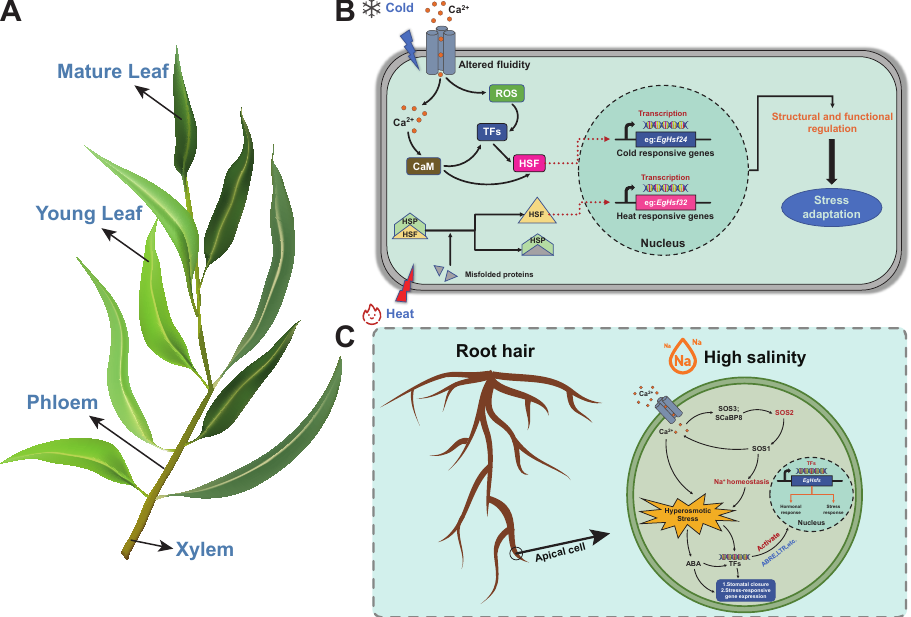
Figure 9. Abiotic stress (salt and temperature) response mechanisms of the Hsf gene in Eucalyp- tus . ( A ) Schematic diagram of the morphology of the Eucalyptus branch. The diagram includes mature leaves, young leaves, phloem and xylem. These parts (including the roots) are the key parts of Eucalyptus in relation to abiotic stress perception and response. ( B ) Schematic diagram of the temperature stress response mechanism and signaling for this experiment. Low-temperature stress may lead to elevated levels of calcium ions and reactive oxygen species in the cytoplasm of the cell, which are recognized by TFs or act directly on the responding genes before entering the nucleus to participate in the gene expression response to cold stress. In the present experiment, EgHsf24 was the best performer in response to the corresponding stress, while high temperature caused the denaturation of proteins in the cell, resulting in misfolding, which led to the activation of sensory genes, thus entering the nucleus to cause expression in response to heat stress. EgHsf32 performed well in response to heat stress in this experiment. The final result was the enhancement of plant tolerance to temperature stress. ( C ) Schematic diagram of the mechanism of salt stress response and signaling in this experiment. Under high-salt conditions, the receptor module on the cell